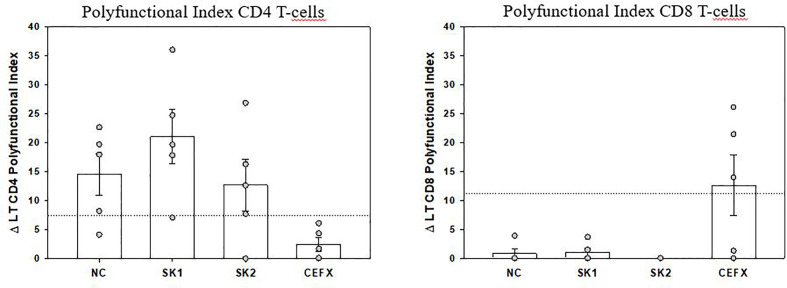
Polyfunctional Index (PI) of SARS-CoV-2–specific CD4 and CD8 T-cells. The PI of antigen-specific CD4 and CD8 T-cells from 5 patients was calculated as previously described (18, 20) for each antigen stimulation. Data are expressed after subtraction of “background polyfunctionality” of medium-stimulated cells (Δ PI). Dotted lines correspond to PI positivity threshold as determined at 3SD of 30 negative controls measures for CD4 and CD8 T-cells. Bars are shown as mean ± SEM. LT CD4: CD4 T-cells, LT CD8: CD8 T-cells.